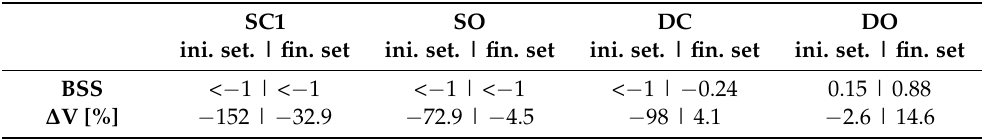
Table 4. Statistics before (ini. set.) and after (fin. set.) calibration for each hydrodynamic condi- tion, including the BSS and the percentage deviations in post-volume between measurements and the simulation. SC1 SO DC ini. set. | fin. set ini. set. | fin. set ini. set. | fin. set ini. set. | fin.